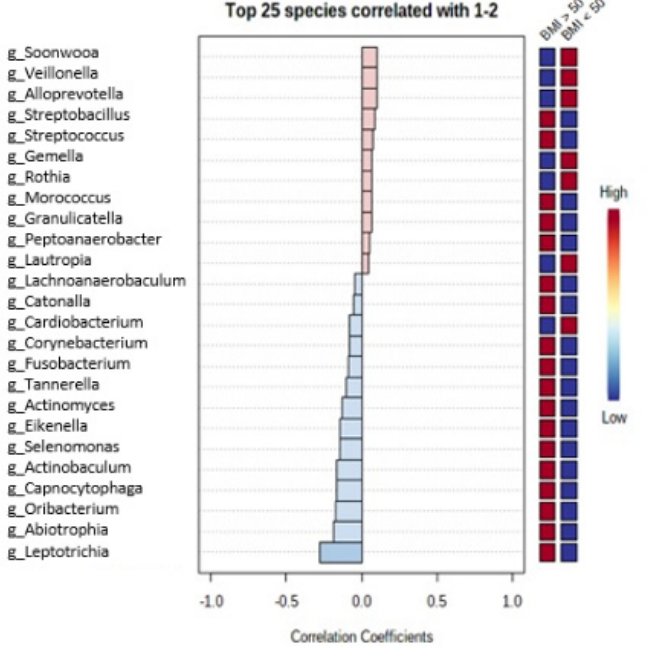
Figure 2. Differences in fecal microbiota between group 1 vs. group 2.